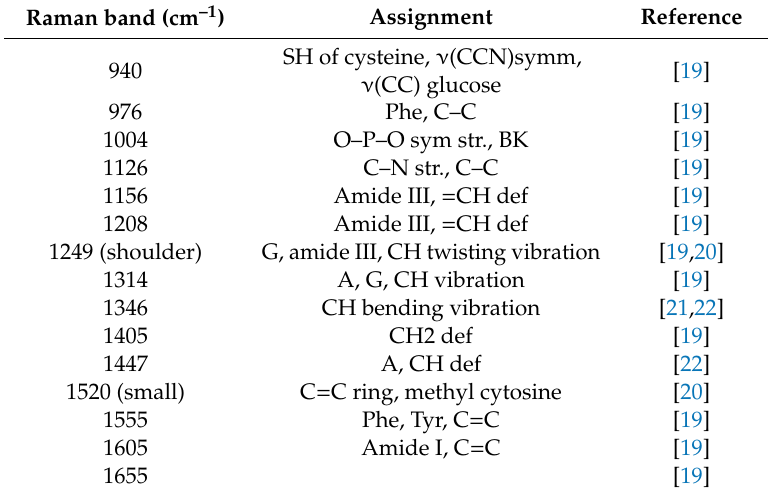
Figure 5. MAGs quantification on secretome of BDCs: ( a ) diagram showing metabolic pathway that underwent the production of advanced glycation products in cancer cells; ( b ) media content of MGA is distributed in order to the correspondent percentage of cells in S phase < (low) or > (high) the mean value of 57% ( p ≤ 0.0001). In ( c ) media content of MGA is distributed in order of the correspondent percentage of cells in S phase < (low) or > (high) the mean value of 17% for healthy group ( p ≤ 0.0001). ( d ) Comparative evaluation by using independent sample test between cancer patients and healthy groups in order of different percentage of S phase and content of MGAs. Table 1. Principal Raman band assignments for the analyzed spectra of healthy, cancer, and intermediate